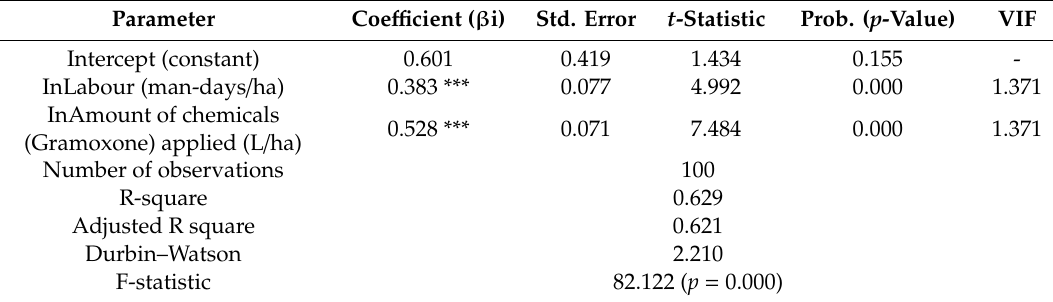
Table 5. Estimates of the production function analysis ( n =